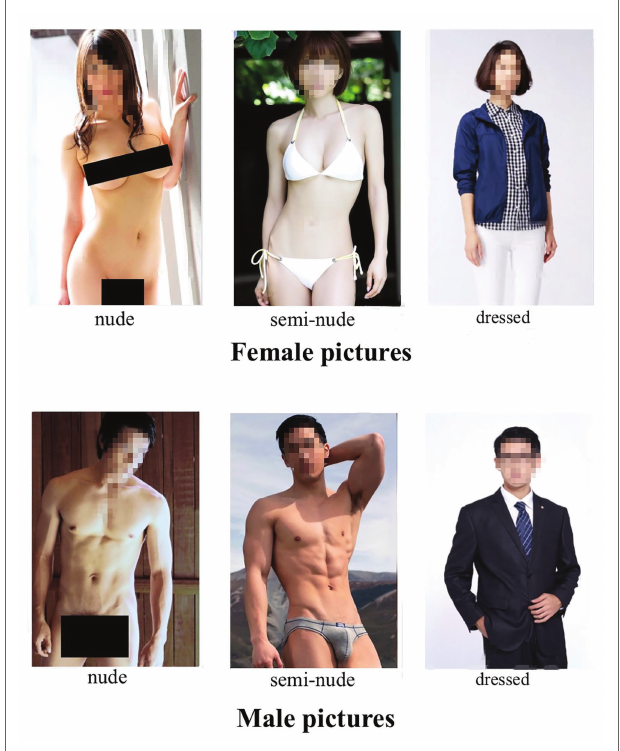
FIGURE 1 | A sample image of males and females from each